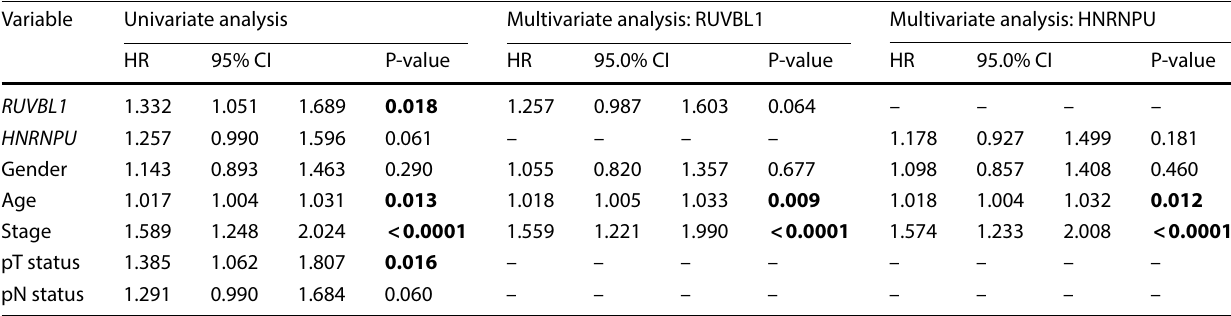
Table 4 Univariate and multivariate Cox proportional hazards models for OS of the TCGA patients with NSCL (n = 761)